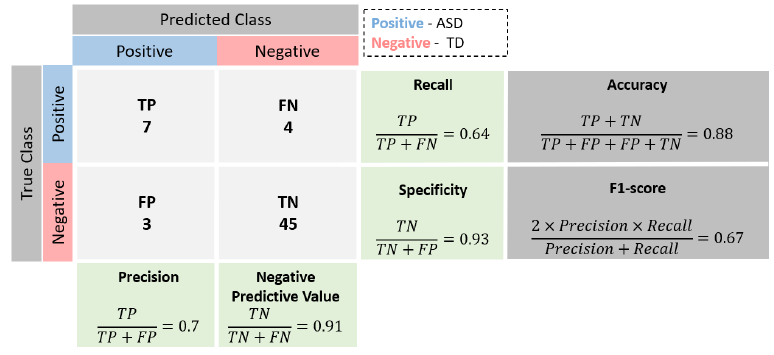
Figure 4. Contingency table and respective precision, recall, negative predictive value, specificity, accuracy, and F1-score